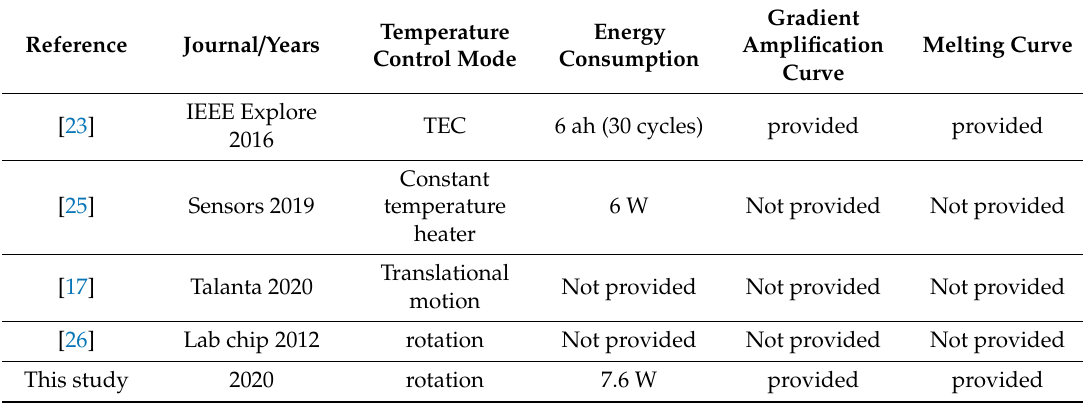
Table 1. The comparison of portable PCR